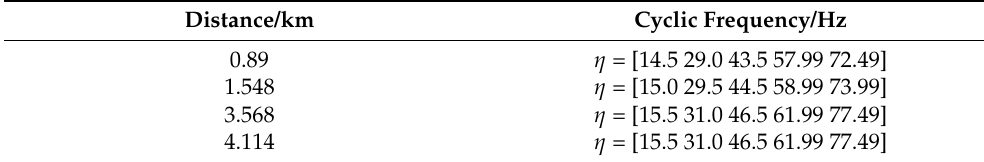
Table 2. Detection results of cyclic frequencies at different